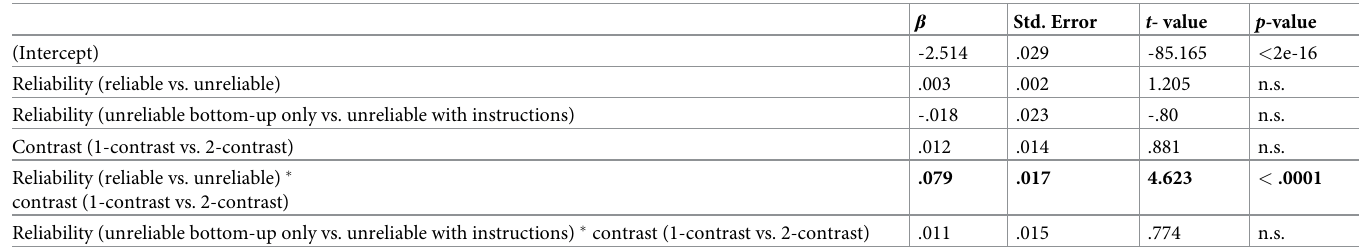
Table 4. Summary of final linear mixed model of fixation proportions in Experiments 1 and 2. Reliability conditions were Helmert coded (for details, see text).